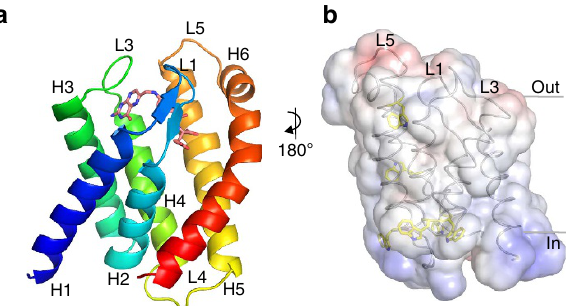
Fig. 2a, ECF–FolT1: Supplementary Fig. 5). Both ECF transpor-